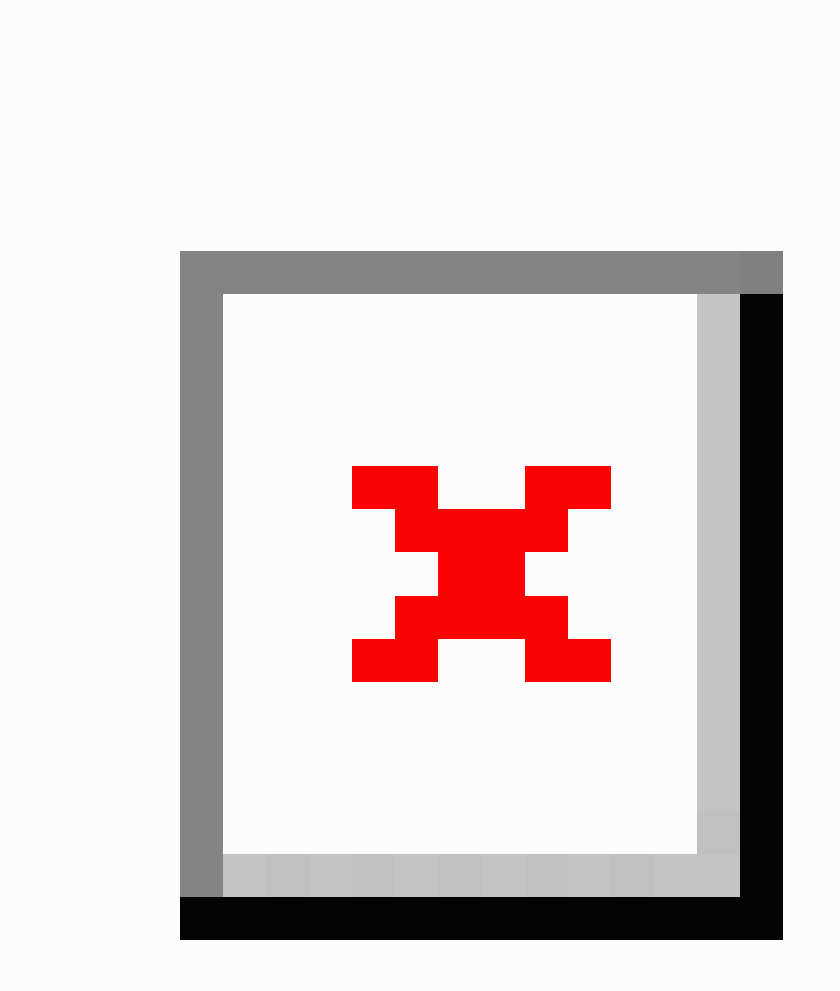
Figure 1. Mean gestational weight gain (kg) for women in the usual care, remote, and in-person groups. The whiskers represent standard error.